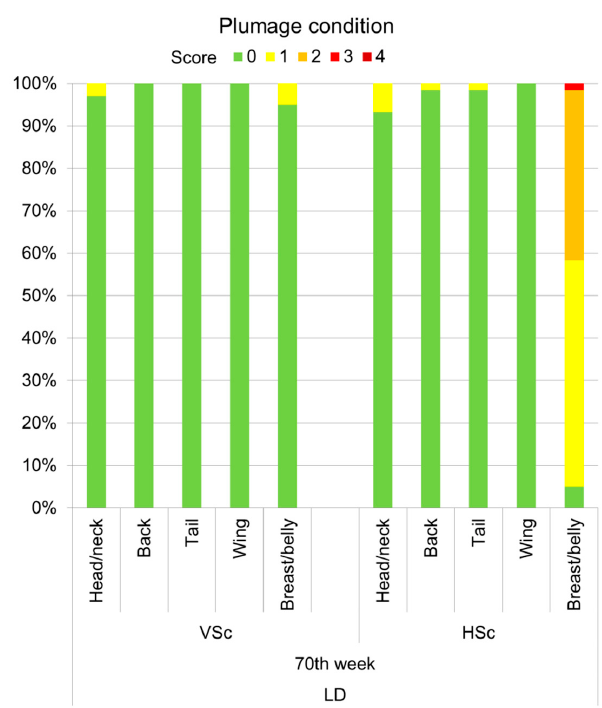
Figure 5. Proportions of LD hens with different plumage scores (0 (best) to 4 (worst)) for individual body regions given via VSc ( n = 200 hens) and HSc ( n = 60 hens) scoring methods in the 70th week of life. Table 2. Spearman’s rho and the level of significance for plumage score comparisons between VSc and HSc methods for individual body regions in LB+ laying hens (21st–70th week of life). Correlation VSc and HSc Week of Life Head/Neck Back Tail